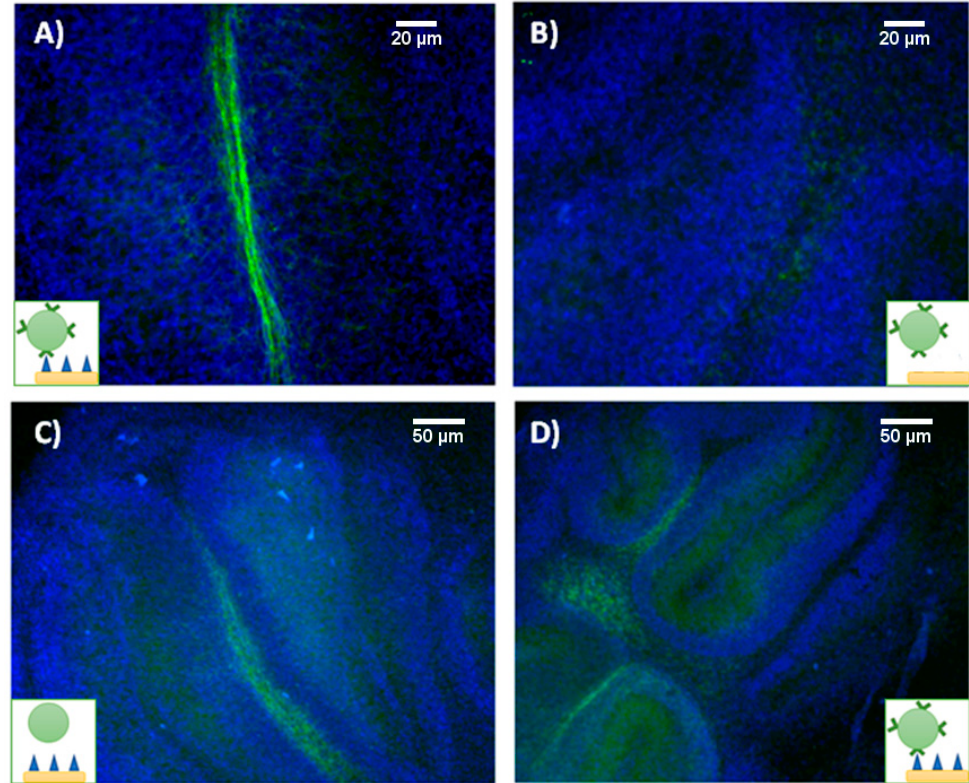
Figure 7. Fluorescence imaging of tissue sections (blue for cell nuclei and green from DIOC18 fluorescent liposomes) incubated with targeting liposomes. ( A ) Healthy and ( B ) demyelinated tissues, incubated with fluorescent anti-MBP liposomes. ( C ) Healthy tissues incubated with control anti-IgG and ( D ) with antimyelin basic protein liposomes.